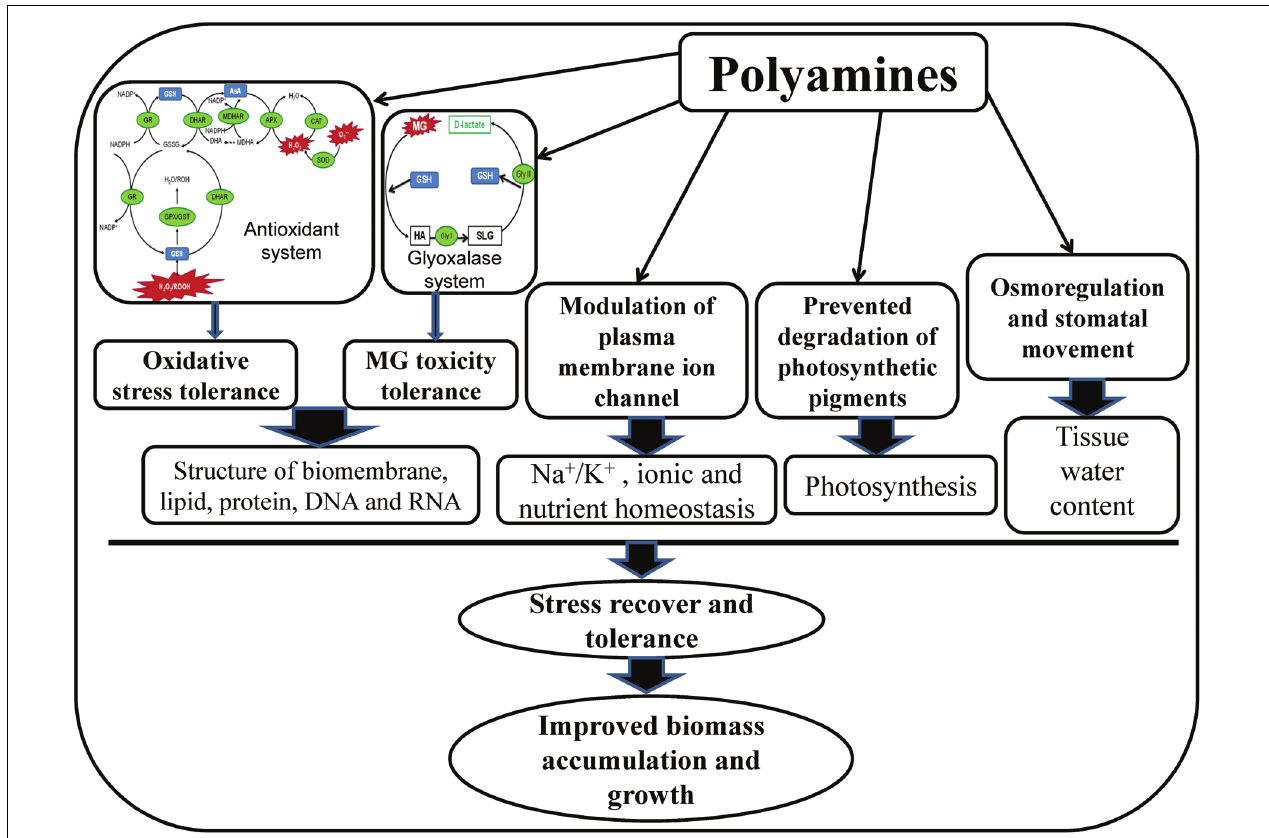
FIGURE 6 | Mechanism of PAs-induced salt stress tolerance. In glyoxalase system, HA indicates hemithioacetal and SLG indicates S- D